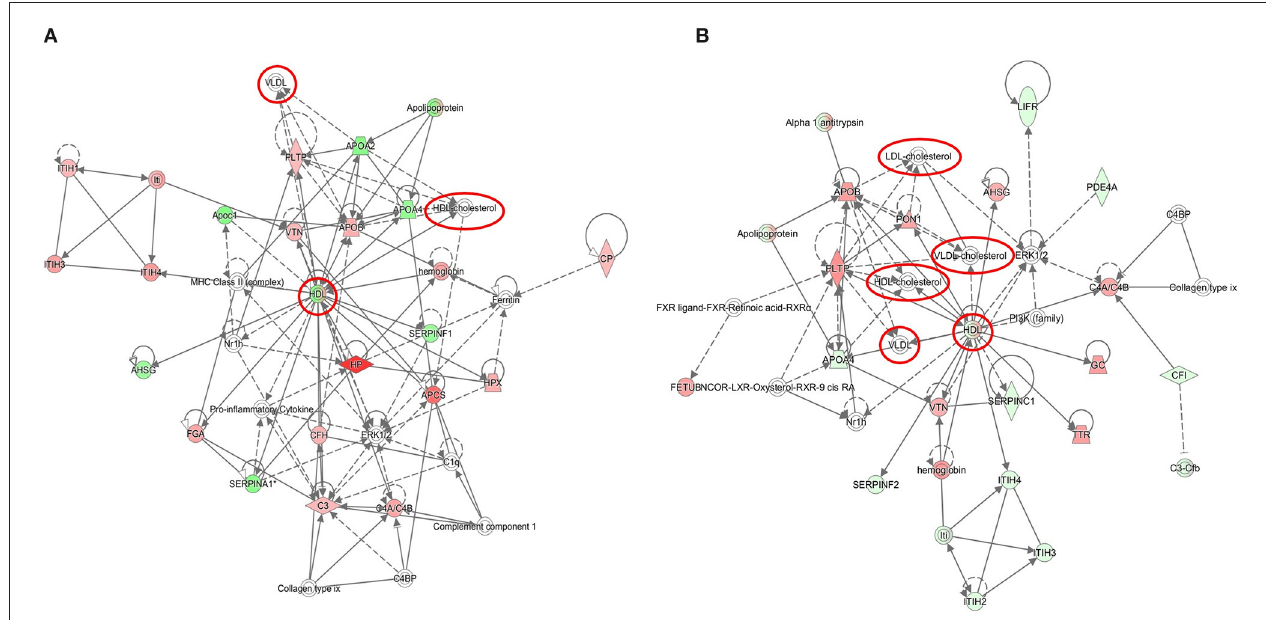
FIGURE 2 | Graphical representation of cholesterol-associated networks based on radiation-induced alterations in the serum proteome. The protein clusters are shown at 8Gy (A) and 16Gy (B) . The upregulated proteins are marked in red and the downregulated in green. The nodes represent proteins connected with arrows; the solid arrows represent direct interactions and the dotted arrows indirect interactions. The cholesterol nodes are marked inside red circles and boxes. The IPA codes and corresponding full protein names are shown in Table 1 and in Supplementary Table 1 . The analysis was performed using the Ingenuity Pathway Analysis (IPA)